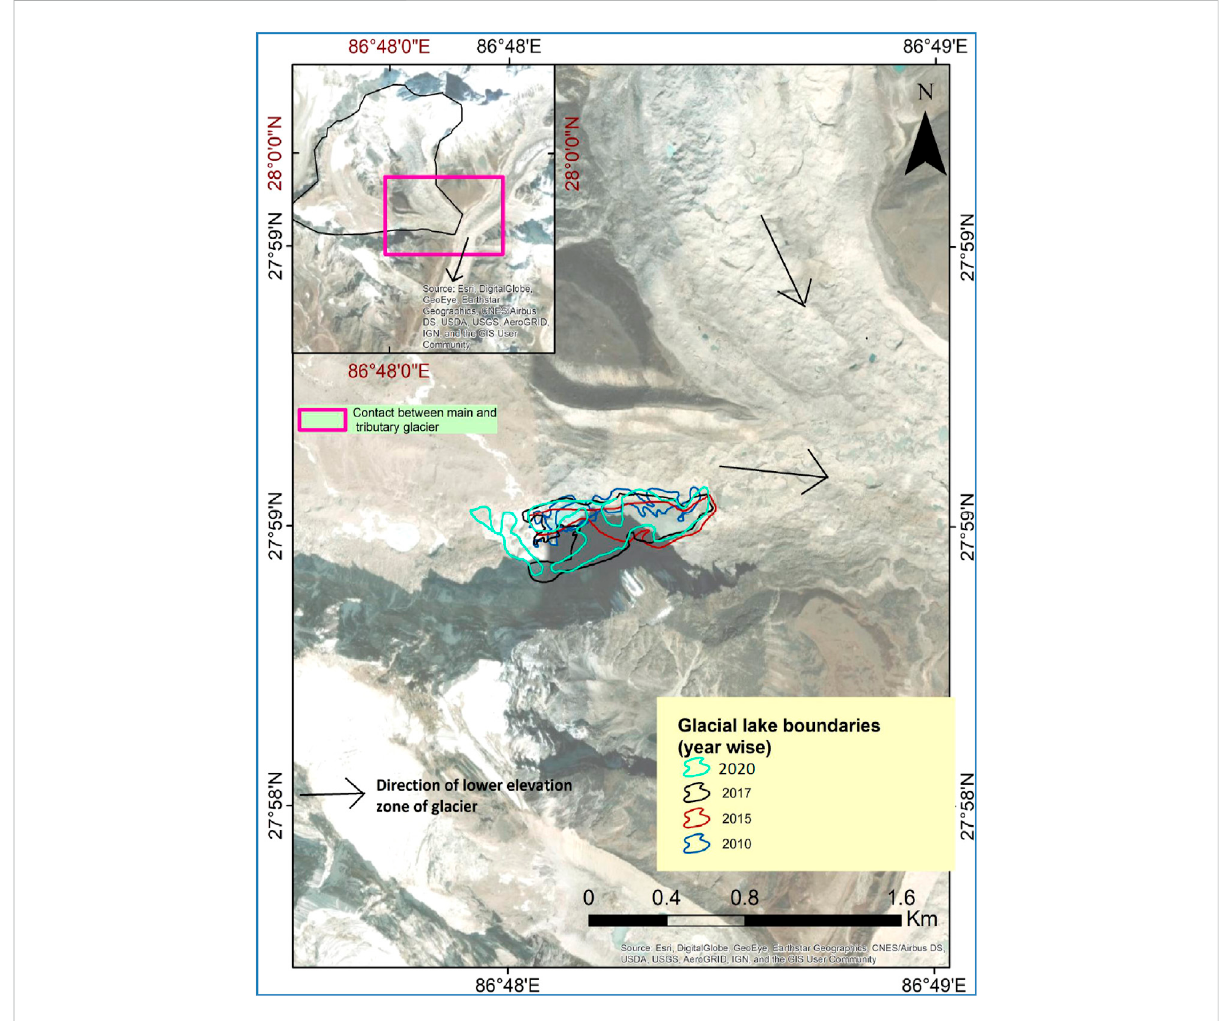
FIGURE 4 New proglacial lake is forming by coalensing at the tributary glacier (changri Nup) of Khumbhu glacier. Here, lake polygon in different years is shown in various